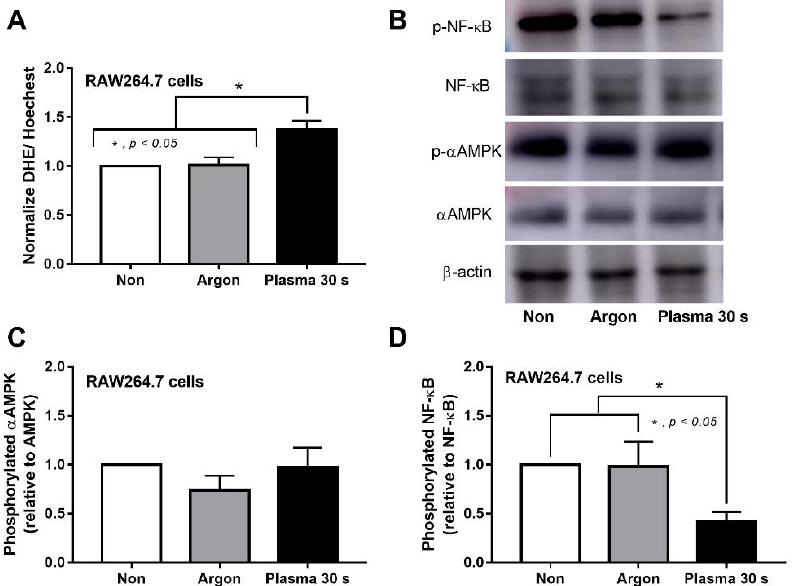
Figure 2. Characteristics of macrophages (RAW264.7 cells) without stimulation (Non) or after stimulation with argon gas alone (Argon) or plasma flux for 30 s (Plasma 30 s) as evaluated by intracellular reactive oxygen species (ROS) using dihydroethidium (DHE) fluorescent dye (neutralized by Hoechest nucleus staining dye) ( A ) and abundance of phosphorylated NF- κ B-p65 (p-NF- κ B) and phosphorylated- α AMPK (p- α AMPK) with the representative pictures of Western blot analysis ( B – D ) are demonstrated. Independently triplicated experiments were performed.